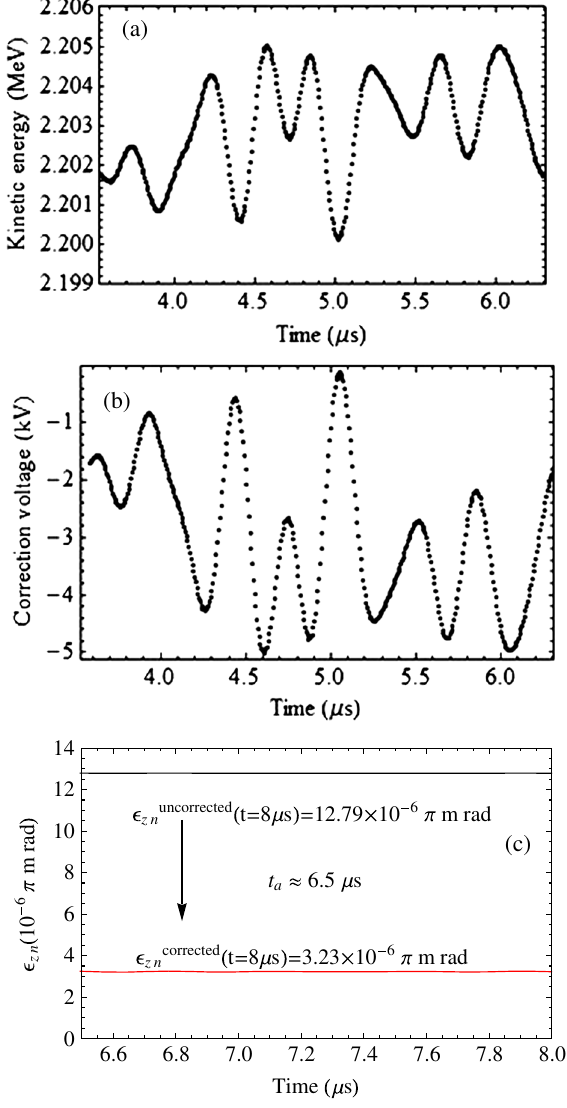
FIG. 6. (a) Beam kinetic energy profile detected at D. (b) Correction voltage profile applied at C. (c) (cid:1) for the Rb beam after the one-step